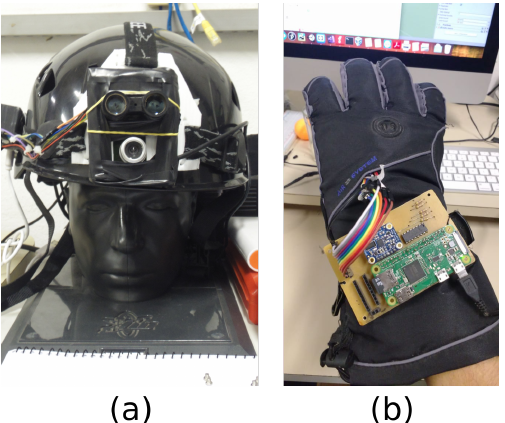
Figure 7. Prototypes exclusively considered during evaluation of platform initialization time: ( a ) wearable helmet prototype. ( b ) Wearable glove